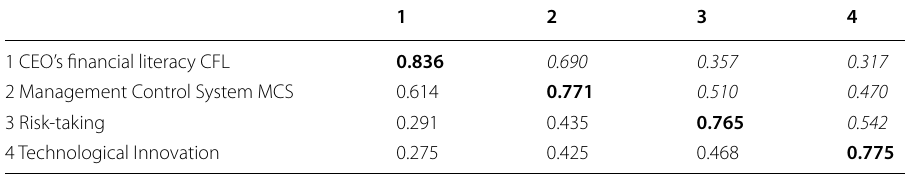
Table 4 Discriminant validity. Fornel & Larcker and HTMT